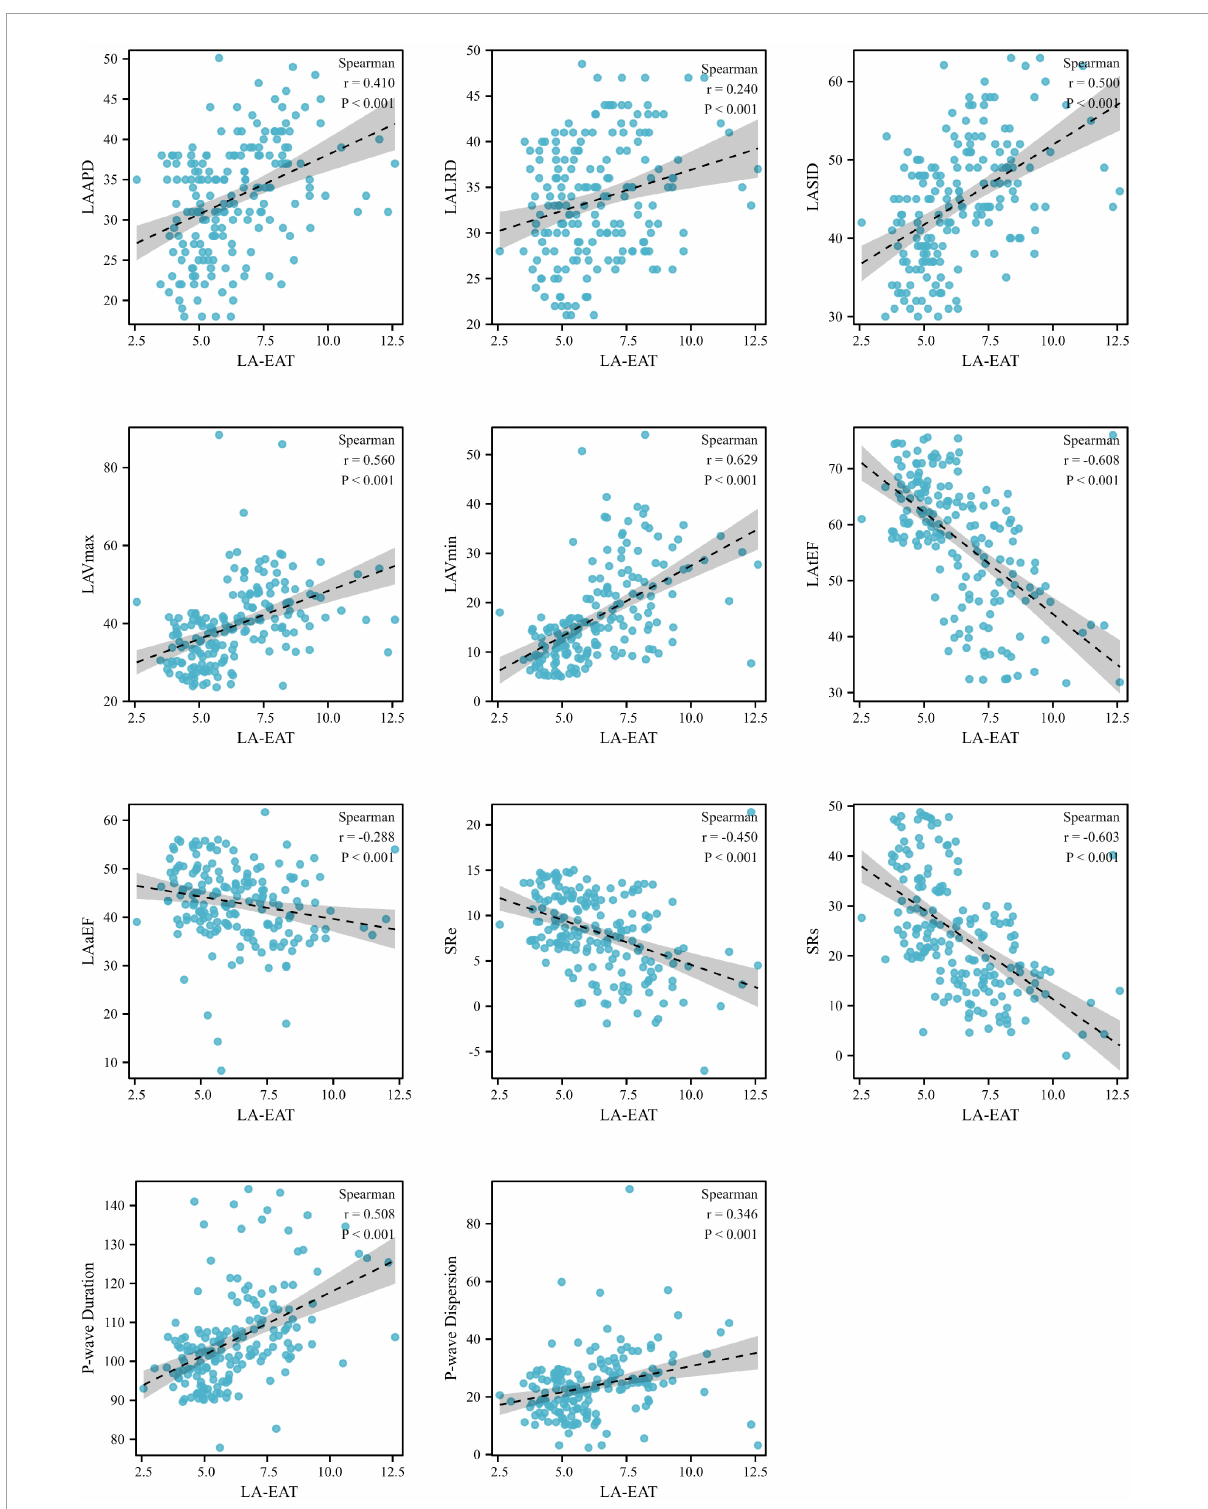
FIGURE6 Linear trends between LA-EAT and LA indexes in AF patients. AF, atrial fibrillation; LV-EAT, mean Epicardial adipose tissue thickness surrounding left ventricle; AF, atrial fibrillation; LAAPD, LA anteroposterior diameter; LALRD, LA left and right diameter; LASID, superior and inferior diameter of left atrium; LAVmax, LA maximum volume; LAVmin, LA minimum volume; LAtEF, LA total emptying fraction; LAaEF, LA active ejection fraction; SRs, strain rate during ventricular systole; SRe, strain rate during early ventricular